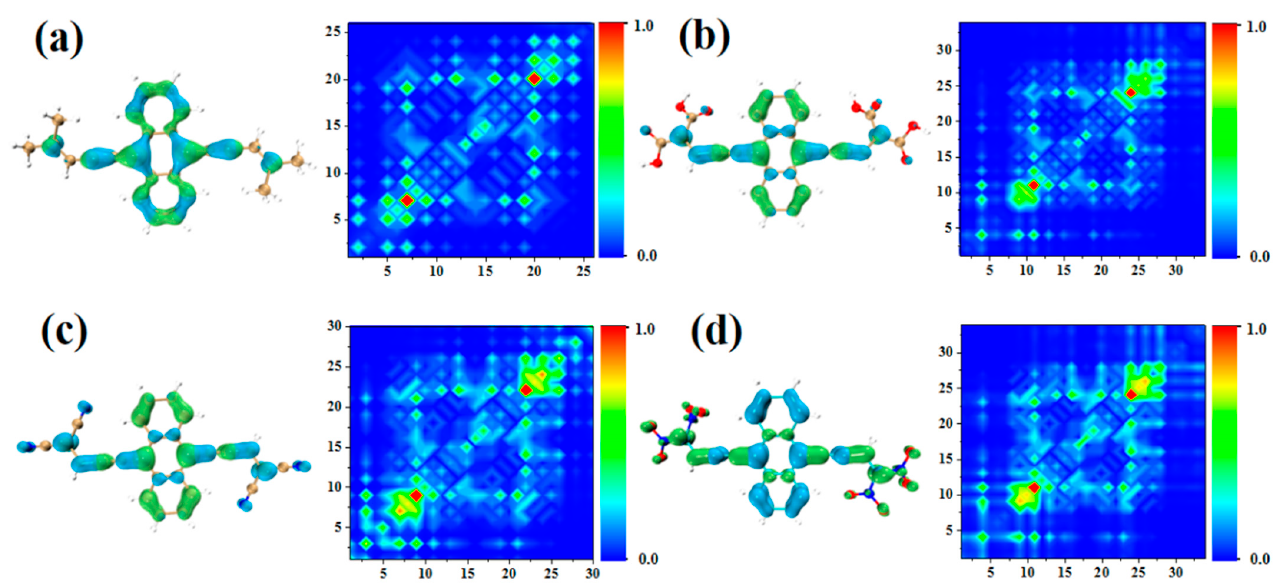
Figure 4. The one-photon absorption transition characteristics of -H ( a ), -COOH ( b ), -CN ( c ) and -NO 2 ( d ) conjugated molecular systems. The green and blue isosurface represent the hole and electron density,